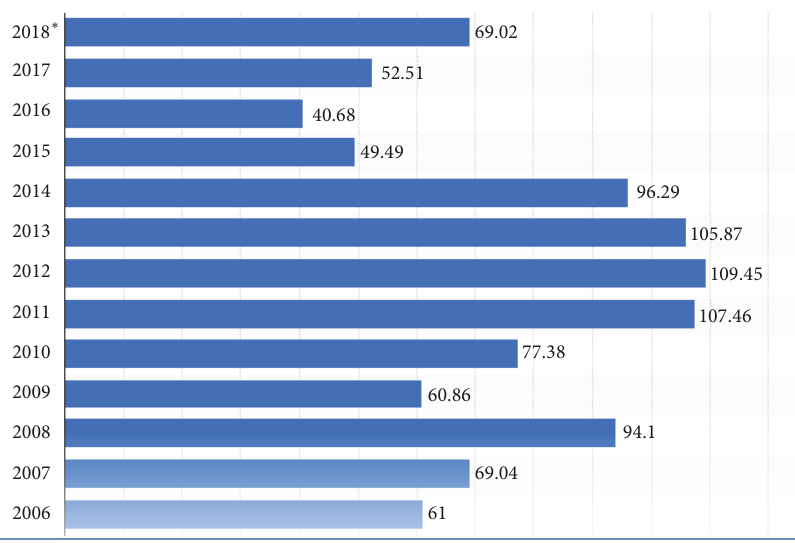
Figure 1: Average annual OPEC oil price (in the US dollars per barrel). Note: this figure is slightly modified from original data source [1]. Vertical line represents year and horizontal line shows oil price per